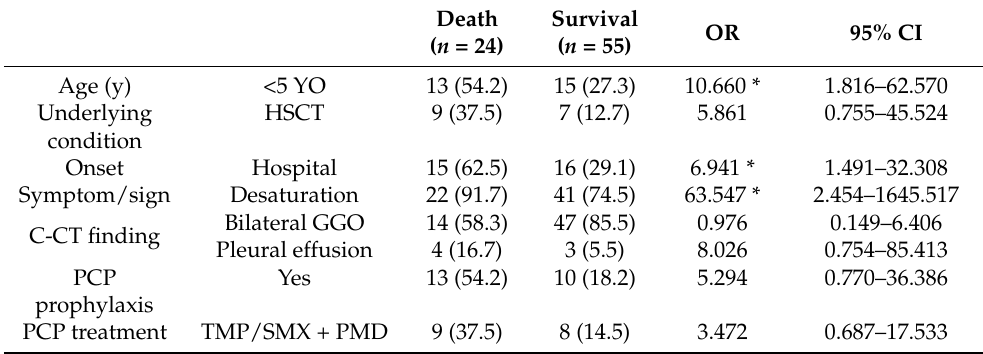
Table 3. Multivariable analysis for mortality in children with clinical PCP, n